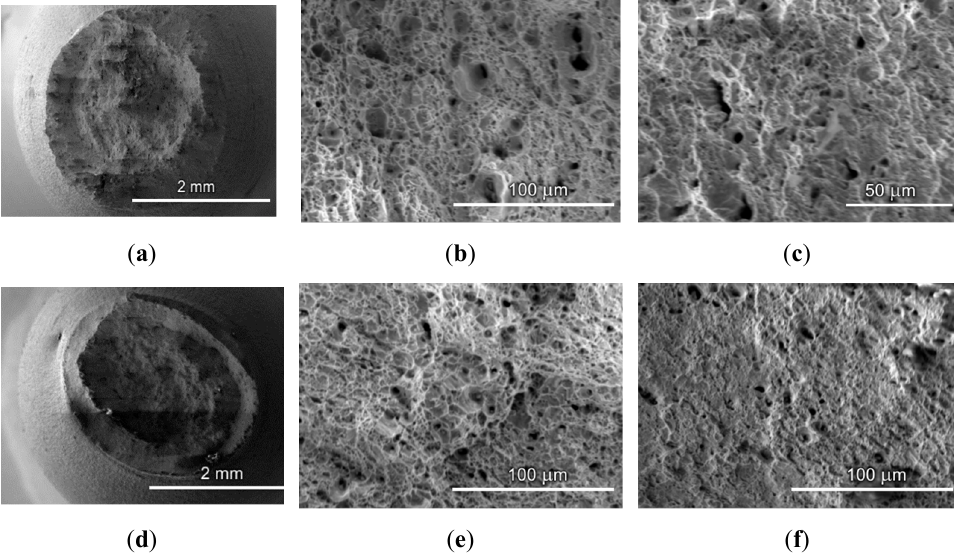
Figure 5. SEM micrographs of the fracture surface of the failed specimens taken from gas pipelines: ( a – c ) “Novopskov-Aksai-Mozdok” (Nevinnomysskaya CS); ( d – f ) “Gorky-Center” (Gavrilovskaya CS).